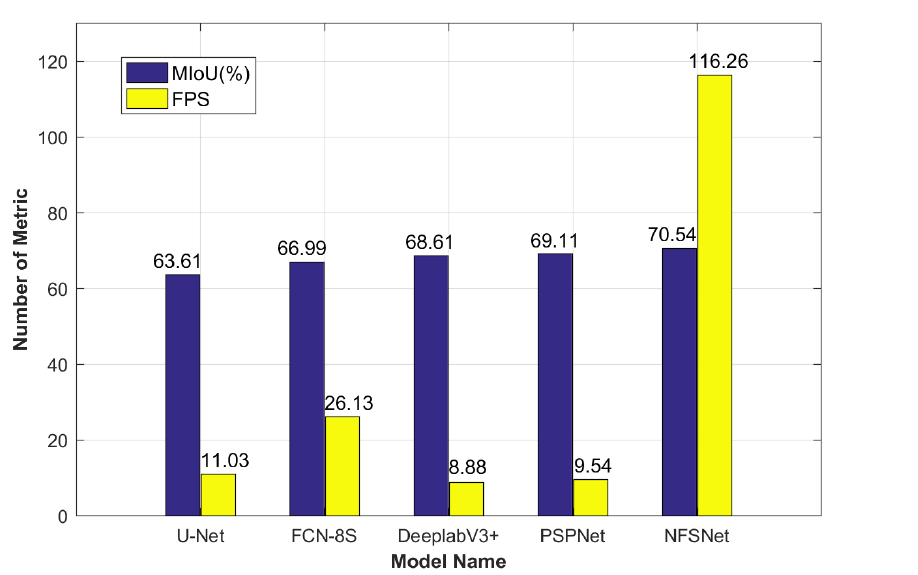
Figure 8. Visualized comparison of model segmentation accuracy and inference speed.